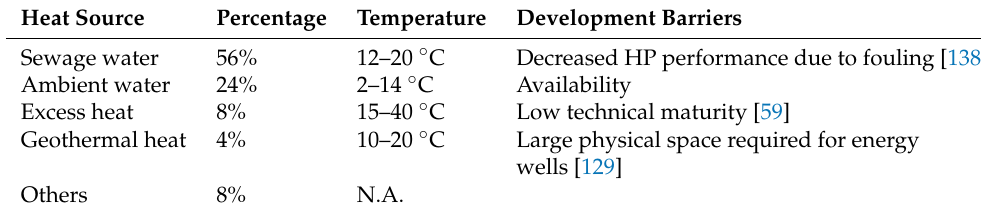
Table 7. Major heat sources for existing HP-based DH systems in Europe